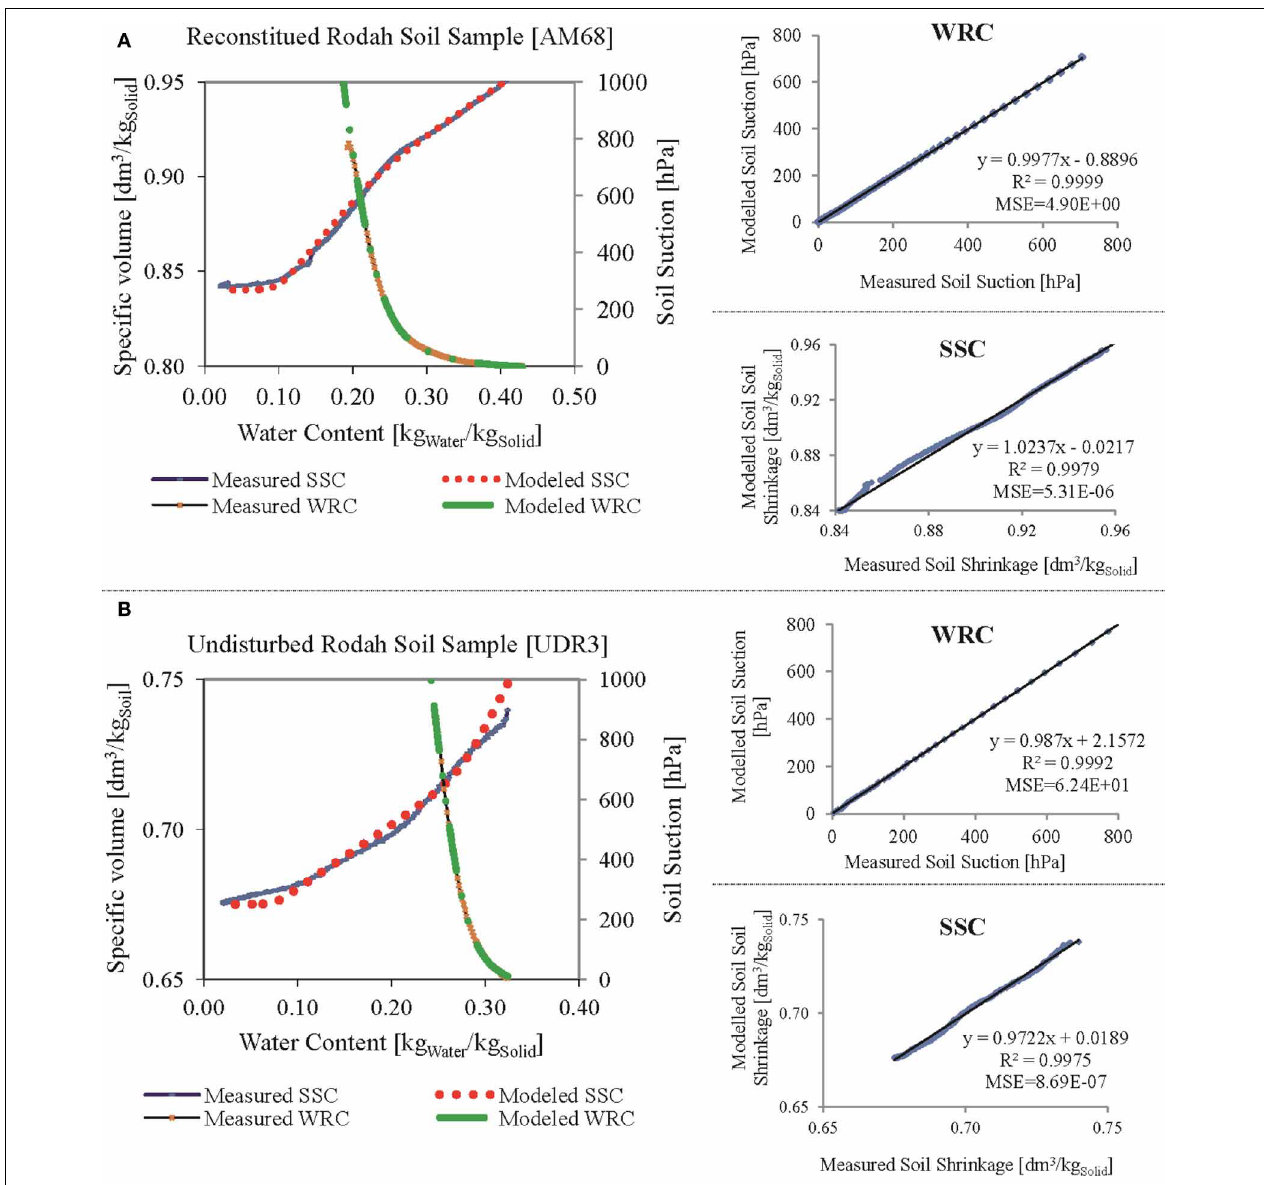
FIGURE 8 | Examples of modeling the soil moisture characteristic curves for Rodah soil. (A) Reconstituted sample [AM68]; (B) Undisturbed sample [UDR3]. WRC, Water Retention Curve; SSC, Soil Shrinkage Curve; R 2 , coefficient of determination; MSE, Mean Square Errors.